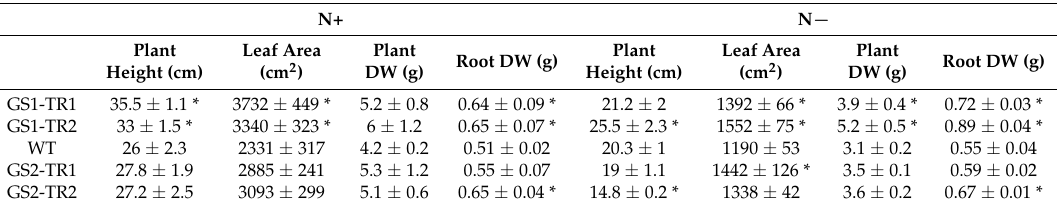
Table 1. Plant height, leaf area, dry weight (DW) and root dry weight of GS1-TR, GS2-TR and WT plants grown under nitrogen-sufficient (N+) and nitrogen-starvation (N − ) conditions.